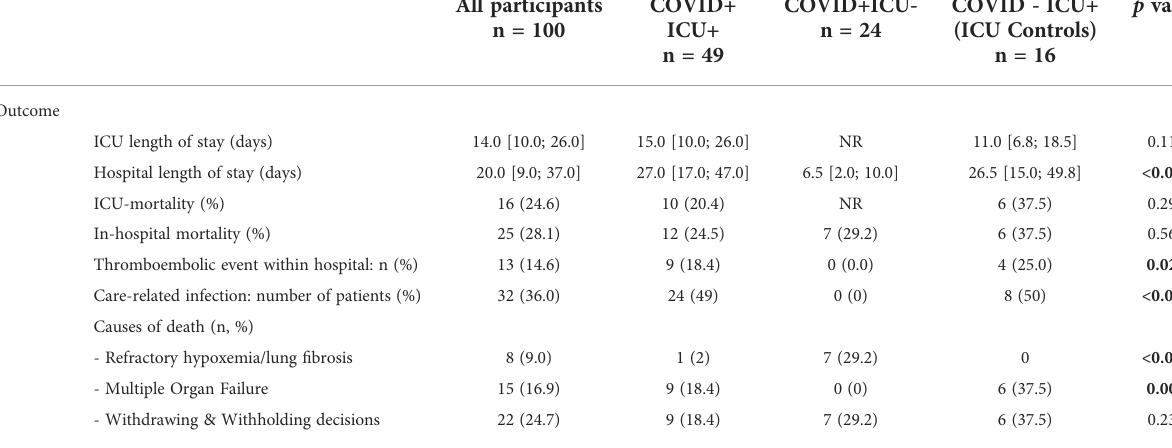
TABLE 2 Outcome issues. Bold values correspond to signi fi cative p